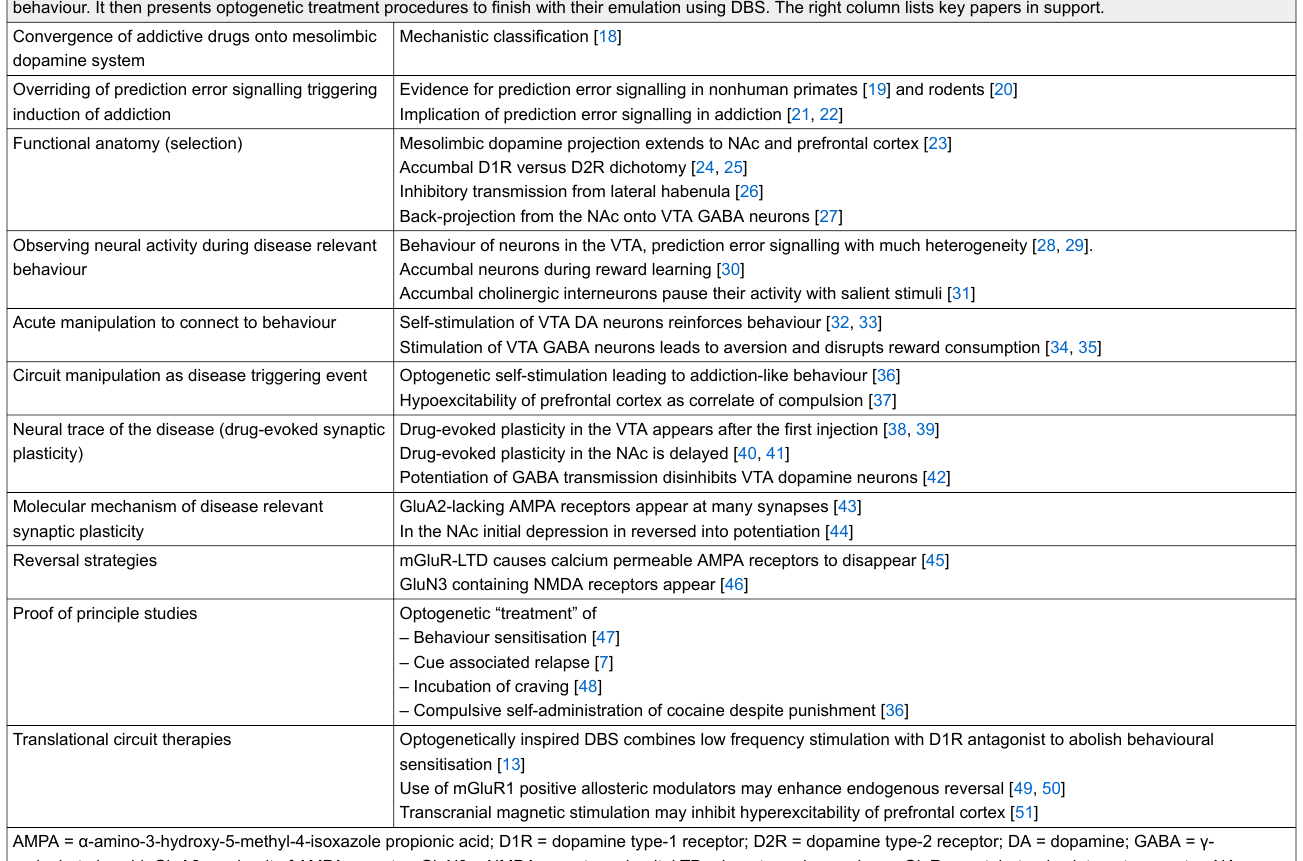
Table 1: Drugs, circuits and addiction: a translational roadmap with a selection of the literature. Using addiction as an example, this table lists a number of steps (left column) that lead from the initial pharmacological effect of drugs on identified molecular targets to “drug evoked synaptic plasticity” that can be linked to drug adaptive behaviour. It then presents optogenetic treatment procedures to finish with their emulation using DBS. The right column lists key papers in support. Convergence of addictive drugs onto mesolimbic Mechanistic classification [18] dopamine system Overriding of prediction error signalling triggering induction of addiction Functional anatomy